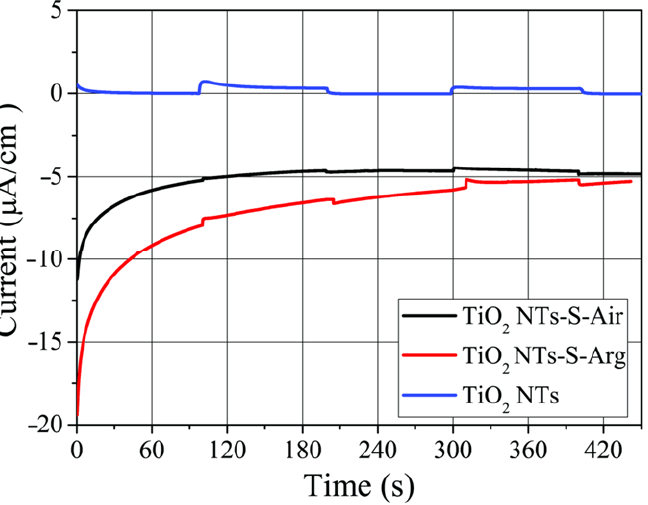
Figure 5. Photocurrent density kinetics of the samples annealed in different media and illuminated by visible light with a wavelength of more than 430 nm.